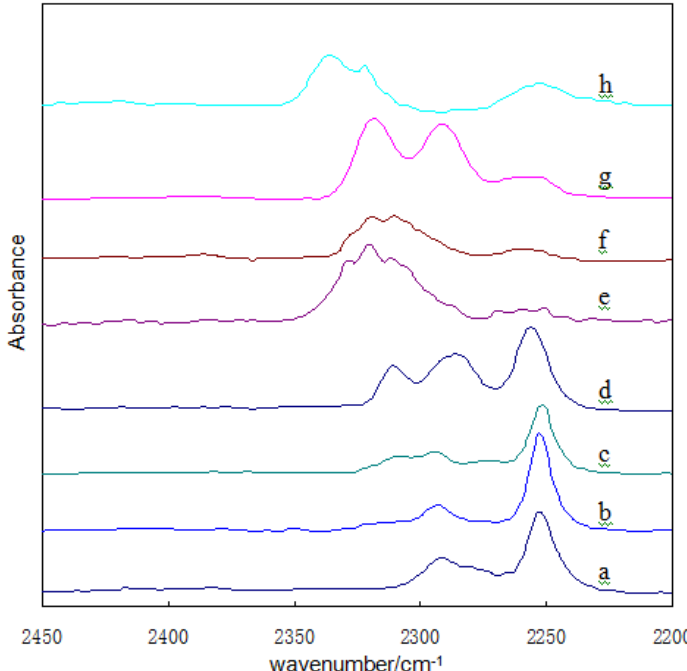
Figure 2. FT-IR spectra of ionic liquid using acetonitrile as IR probe.